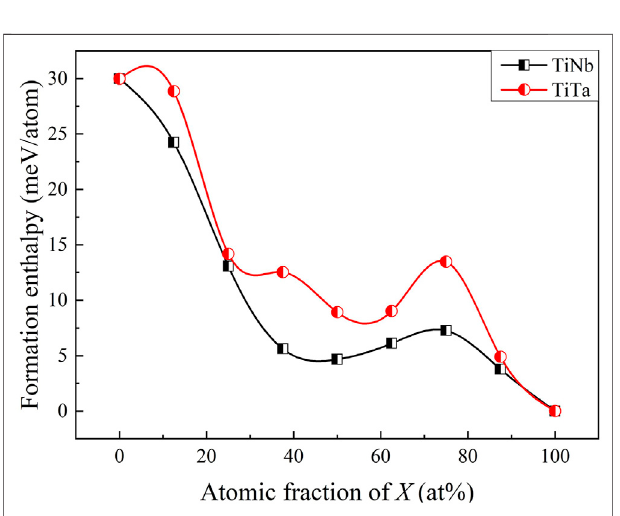
FIGURE 3 | Formation enthalpy of β -Ti X ( X = Nb, Ta) alloys.